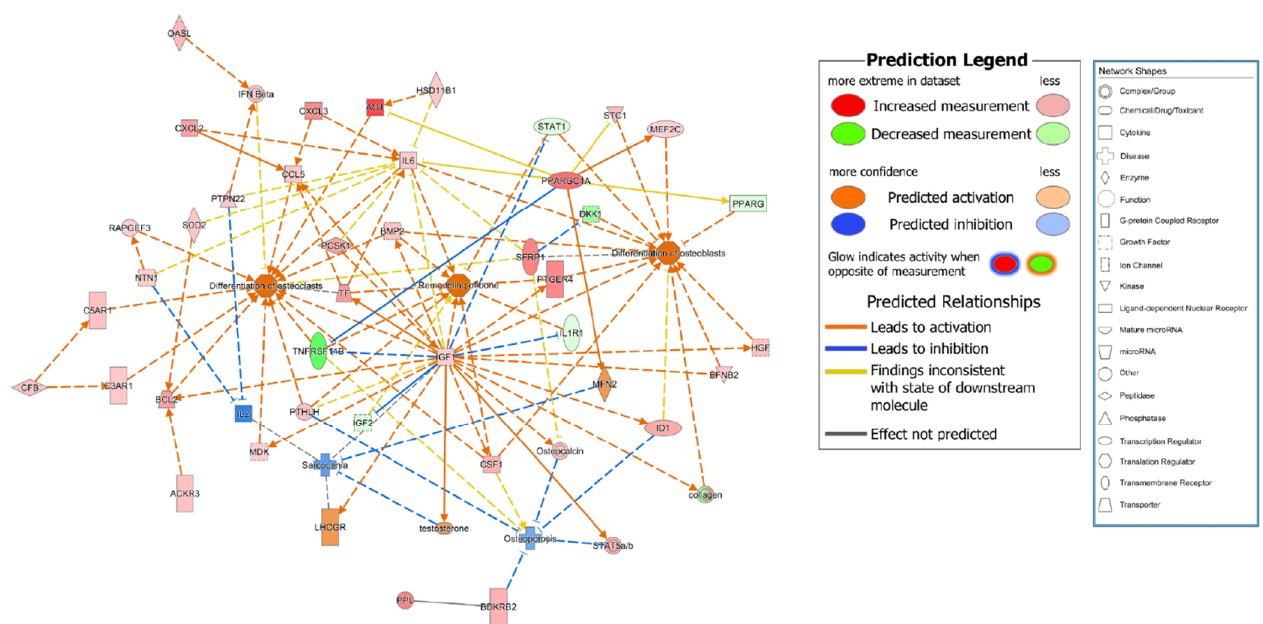
Figure 2. Functional relationship network of genes involved in osteoporosis pathogenesis. Functional relationship network for control subject no. 3 compared with three participants in the osteoporosis group (no. 6, 8, and 9).